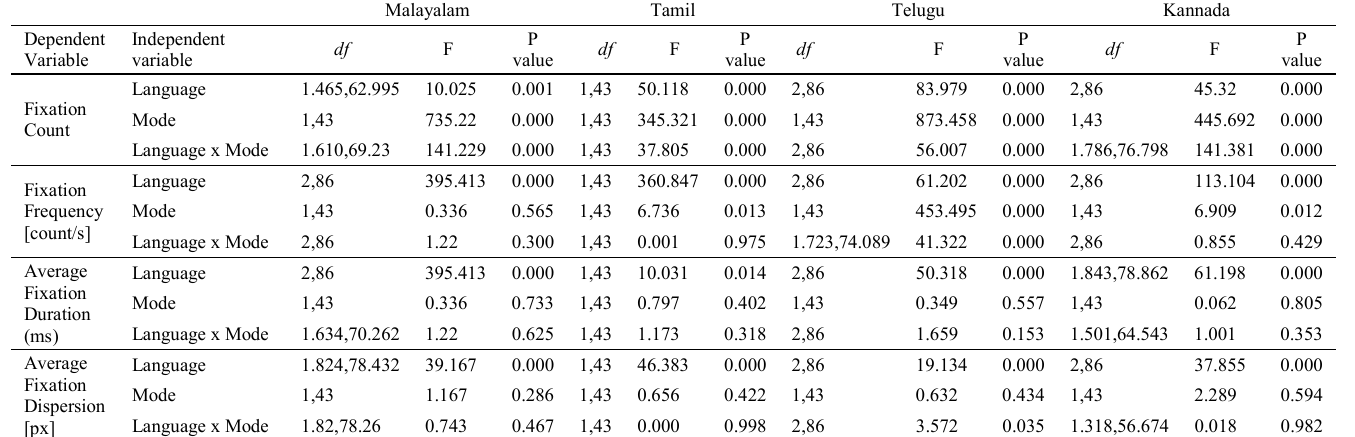
Table 4: ANOVA shows the effect of languages and mode on fixation parameters among dravidian language